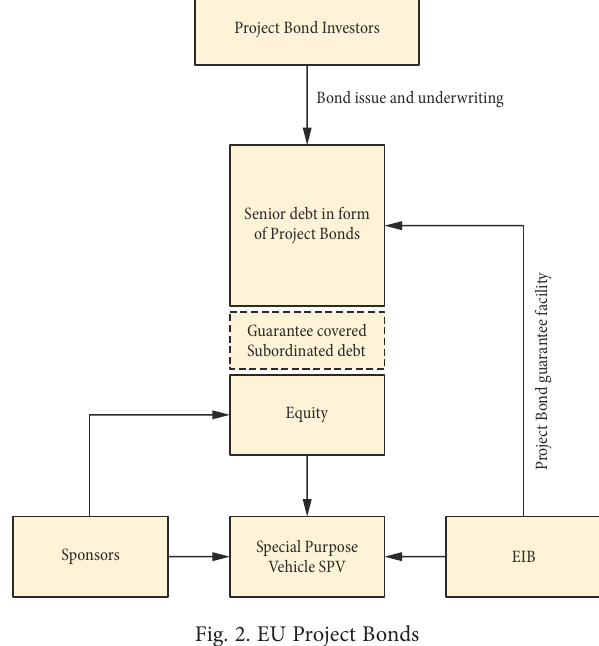
Fig. 2. EU Project Bonds Source : Authors’ figure based on European Commission